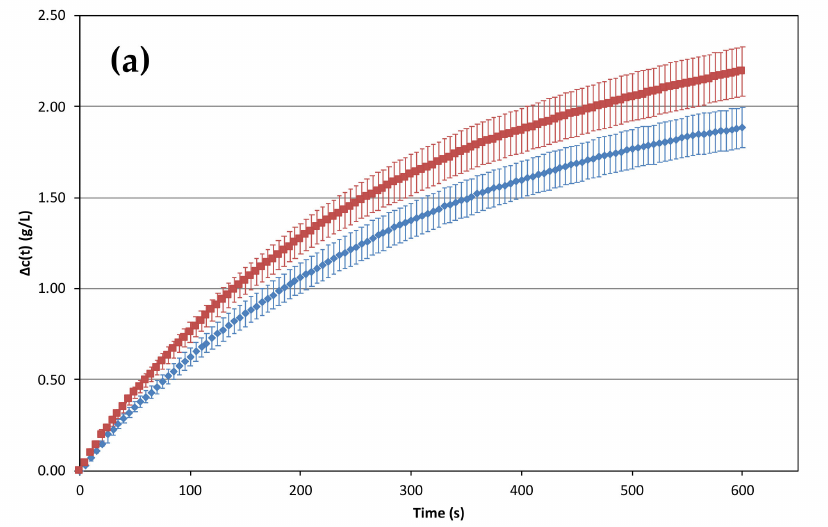
1 Data represent mean value ± standard deviation (n = X). Values with different letters, within a column and for a concentration ( c c 0 ) are significantly different ( P < flute